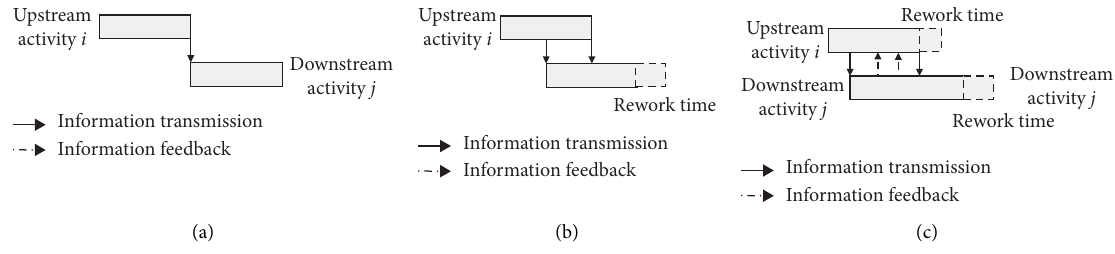
Figure 1: (a) Dependent activity; (b) independent activity; (c) interdependent